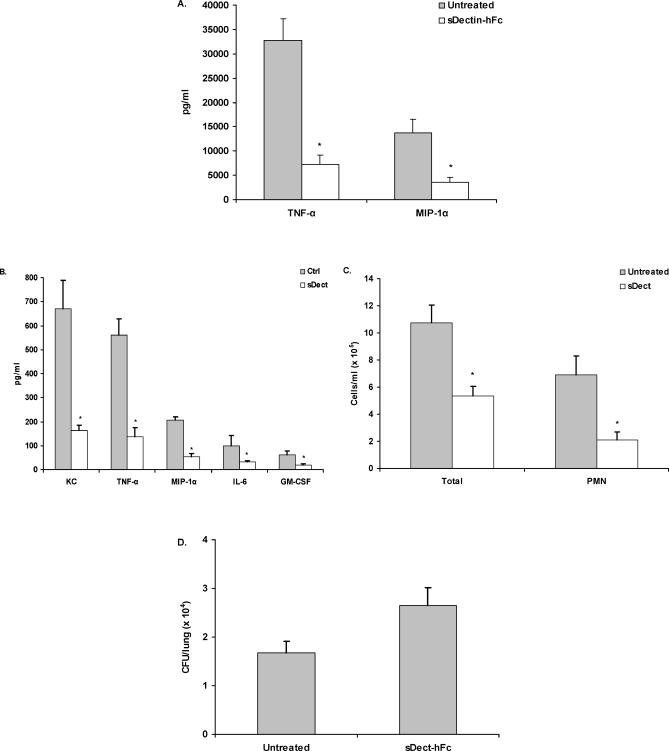
Blockage of Dectin-1-Mediated Inflammation In Vivo after A. fumigatus Lung ChallengeC57BL/6 mice were intratracheally administered live A. fumigatus conidia in the presence or absence of s-dectin-hFc. Mice were sacrificed 24 h later, and a BAL was performed.(A) Alveolar macrophages were co-cultured for 24 h with live A. fumigatus in the presence or absence of s-dectin-hFc (10 μg/ml). Supernatant cytokine and chemokine levels were determined by Bio-Plex or ELISA. (A) illustrates cumulative results from four separate experiments. Asterisks represent significant differences between untreated and s-dectin-1–containing wells (p < 0.05). Data are expressed as mean pg/ml + SEM.(B) Cytokine and chemokine levels in clarified BAL fluid from untreated and soluble (s-dect)–treated mice was measured by Bio-Plex. (B) illustrates representative results from three independent experiments (n = 5–7 mice per group). Asterisks represent significant differences between untreated and s-dectin-1–treated mice (p < 0.05). Data are expressed as mean pg/ml + SEM.(C) Total cell counts (Total) in BALF fluid as enumerated on a hemacytometer. Neutrophil (PMN) concentrations were determined by calculating the percentages of neutrophils in three to five sets of 100 cells and multiplying the percentage with the total BALF cell number.(D) Lungs were excised from non-lavaged–untreated and s-dectin-hFc–treated mice, homogenized, followed by serial 1:10 dilutions, and plated onto potato dextrose agar. CFU/lung were determined after incubating the plates for 24 h at 37 °C. (D) illustrates representative results from three independent experiments (n = 5–7 mice per group).